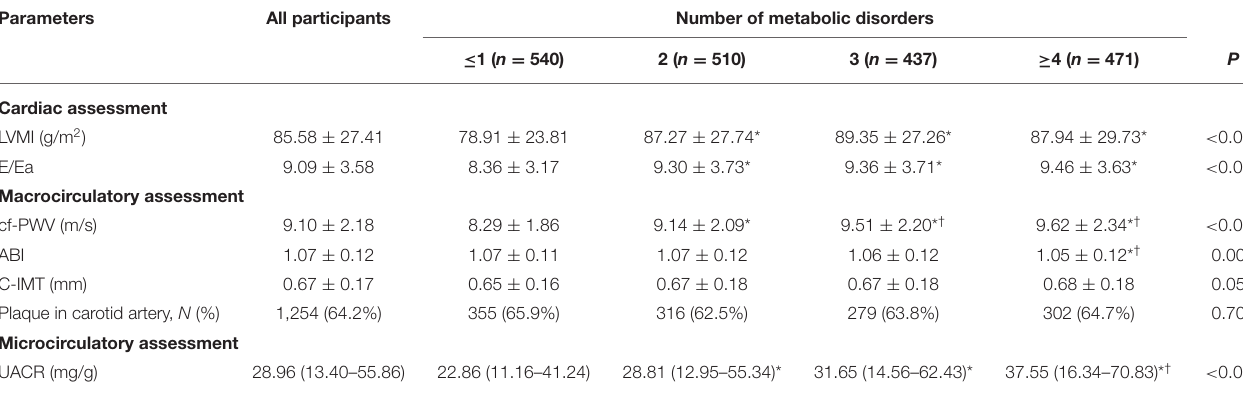
TABLE 2 | Characteristics of cardiovascular assessment according to the number of metabolic disorders. Parameters